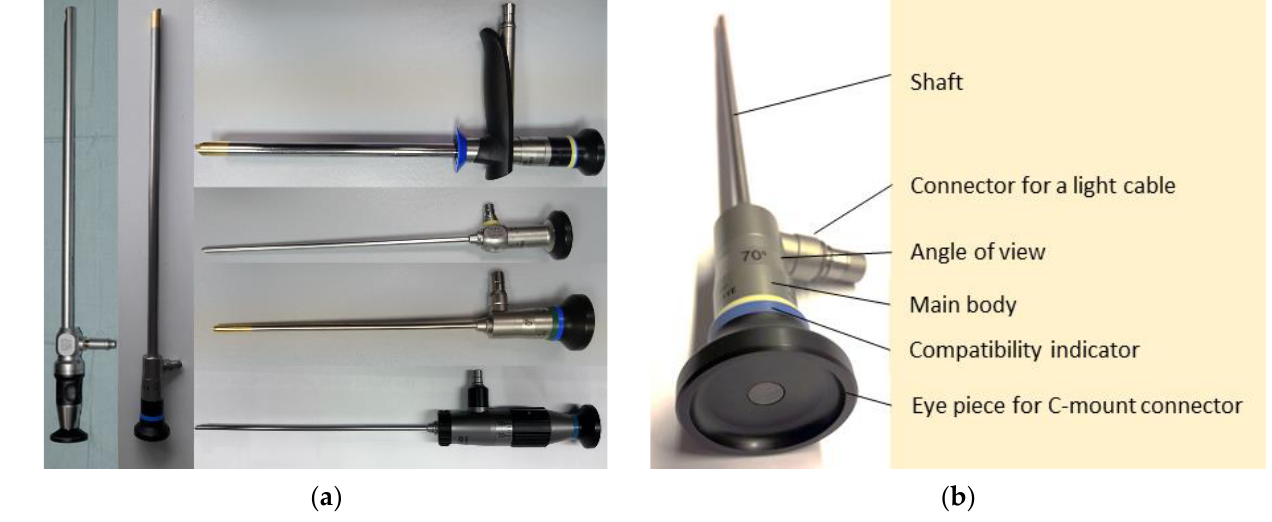
Figure 2. ( a ) Variants of rigid endoscopes, left: KARL STORZ EndoCAMeleon with the steerable field of view 0 – 120°, OLYMPUS 10 mm laparoscope 30 cm, right top-down: OLYMPUS 10 mm rigid laryngoscope with a detachable handle and 70° view, KARL STORZ 4 mm sinuscope 70° view, OLYMPUS 4 mm sinuscope 0° straight view, OLYMPUS 4 mm steerable multi view sinuscope ( b ) general components of a rigid OLYMPUS 4 mm sinuscope with 70° angled view.